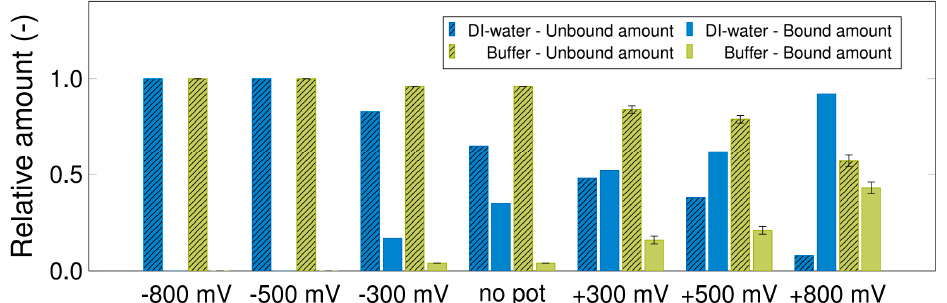
Figure 7. Relative amounts of maleic acid in the adsorption phase (shaded bars) and in the desorption phase (bare bars). Potential-step experiment with 5 g/L maleic acid in DI-water (blue) and 10 mM phosphate buffer (green) (1 mL/min, 50 μ L, 216 nm). The adsorption phase was executed by applying different potentials (x-axis); a potential switch to − 800 mV induced the elution phase. The experiment was performed in a column B with a potential switch after 30 mL (experiments repeated twice).